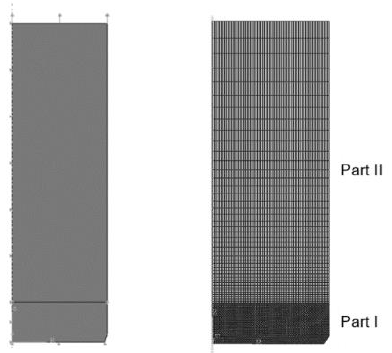
Figure 2. Kinematic boundary conditions (left) and discretization scheme (right).